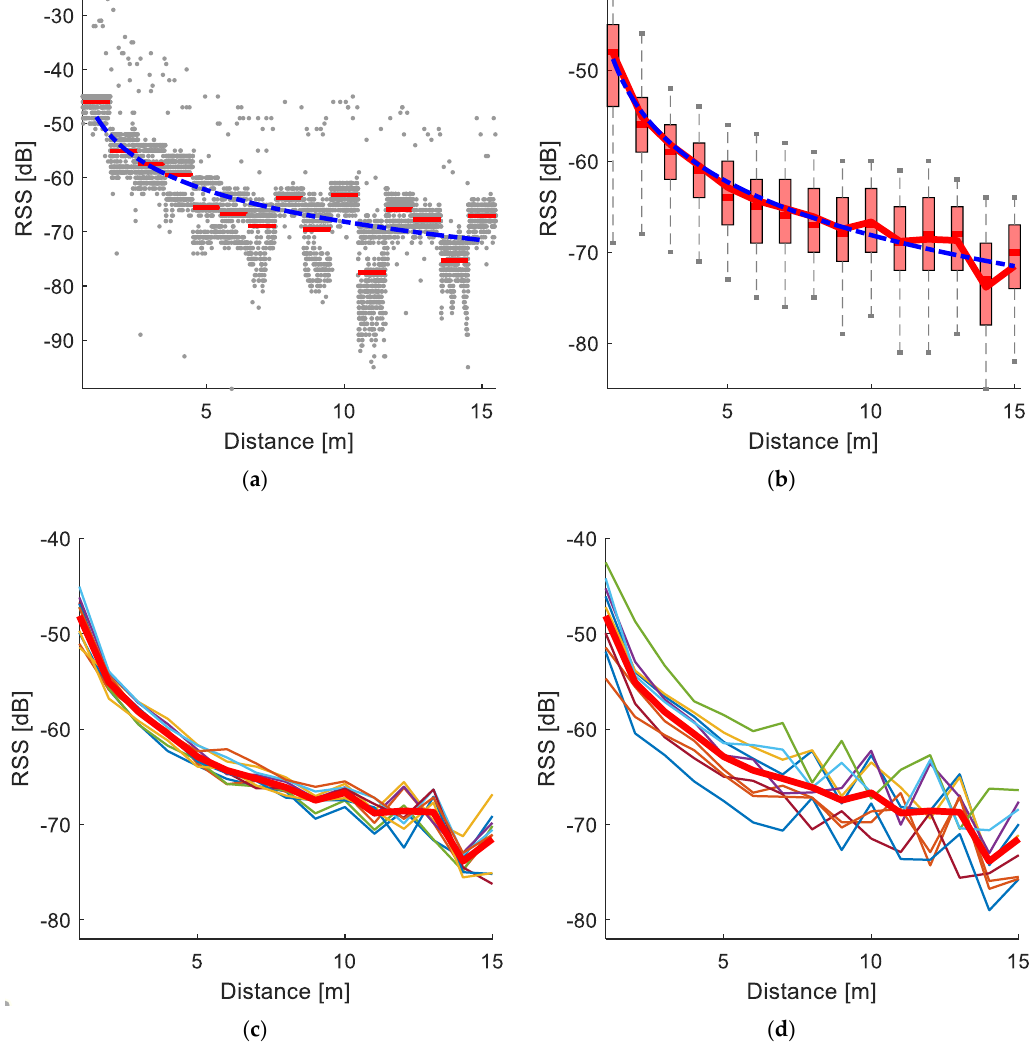
Figure 6. Results of the RSS propagation model experiment. A single experiment with one tag and one receiving station ( a ) with RSS samples is represented by the dots, average for each distance (red lines) and propagation model are described by Equation (1) (dashed line). All the combinations of the 10 tags and the 10 receiving stations with the average line (solid), propagation model (dashed line) and RSS deviation (boxplots) are presented in ( b ). The lines represent the average of all RSS values achieved from all the 10 tags ( c ) and by all the 10 receiving stations ( d ) with the same total average line (solid). The data collected in the RSS propagation model experiment from all the combinations of 10 tags and the 10 receiving stations with the average line (solid line) is presented in Figure 6b. The total RSS propagation model described by the Equation (1) achieved by regression with R 2 = 0.67 (dashed line) had A 0 = − 48.77 ± 4.070 dB, n = 0.84 ± 0.119 (mean ± standard deviation (STD)). This